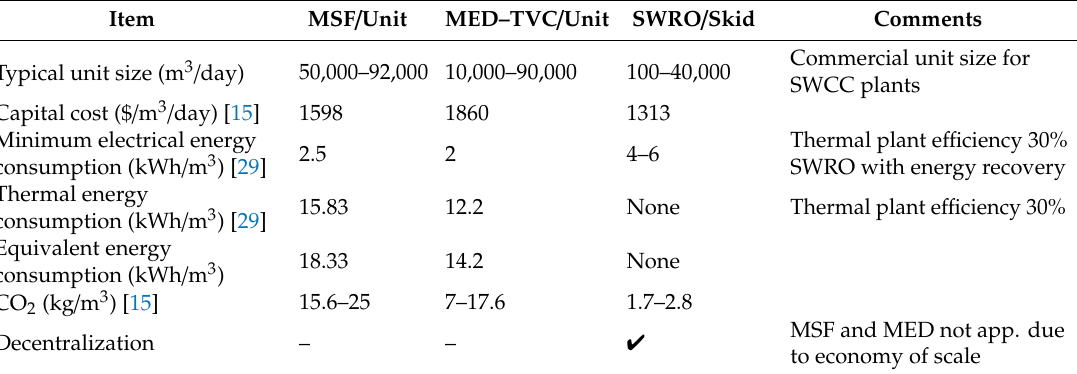
Table 3. Energy consumption and CO 2 emissions for desalination technologies. TVC, thermal vapor